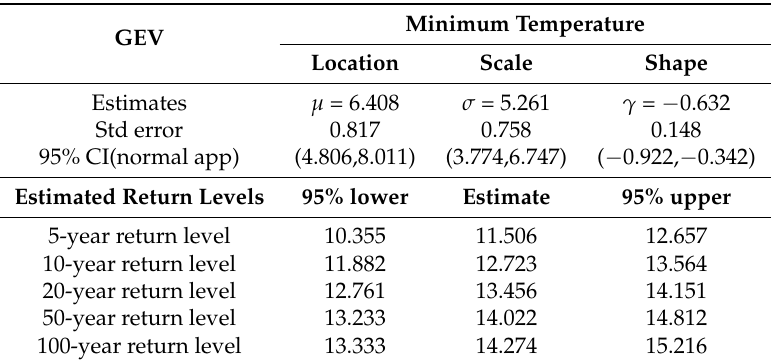
Table 7. GEV estimates of Minimum